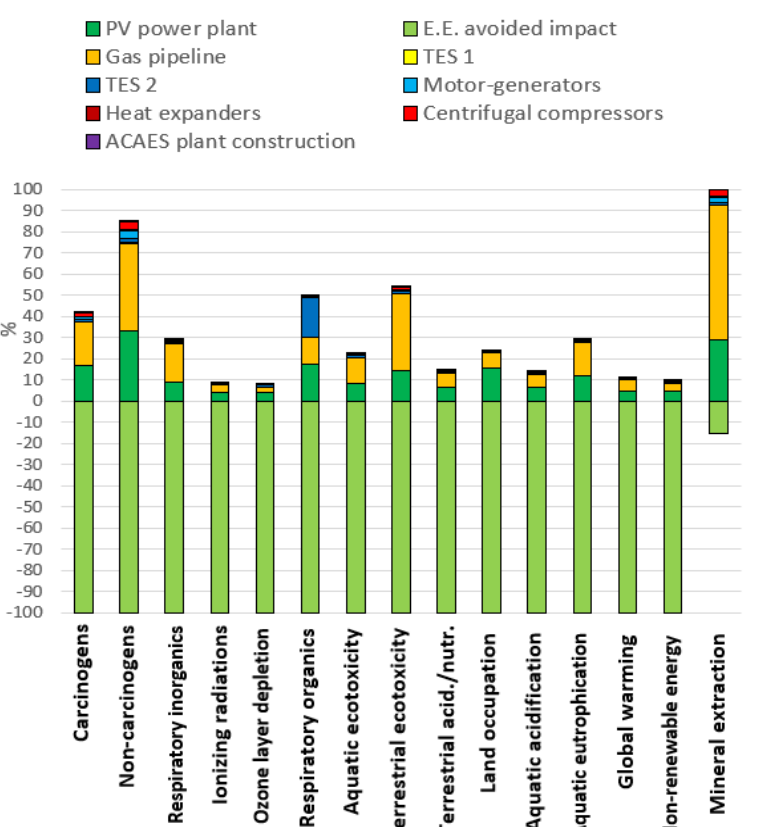
Figure 12. Midpoint indicators for configuration C3 with air storage in a gas pipeline.